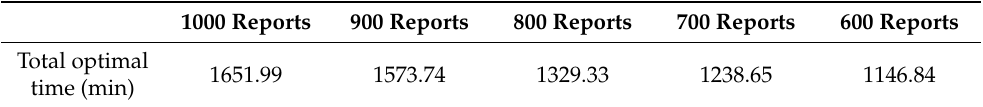
Table 1. Total optimal